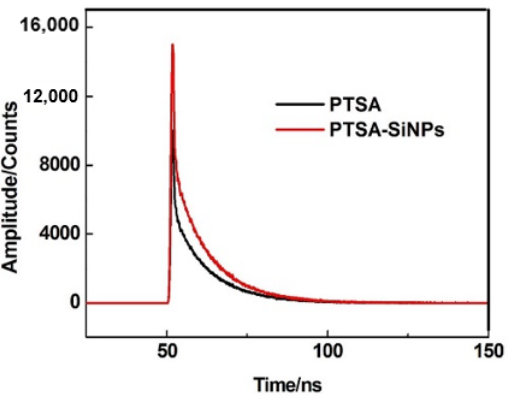
Figure 6. Fluorescence decay curves of PTSA-SiNPs and PTSA in aqueous solution (concentration 10 − 6 M).